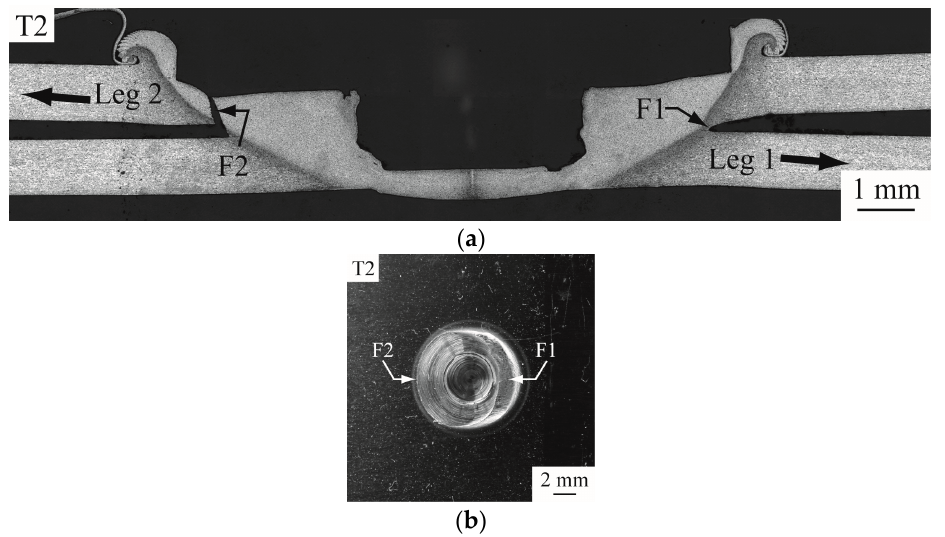
Figure 9. ( a ) An optical micrograph of the cross section of a partially failed FSSW; ( b ) A top view of another failed FSSW on the lower sheet. Materials 2016 , 9 , 677